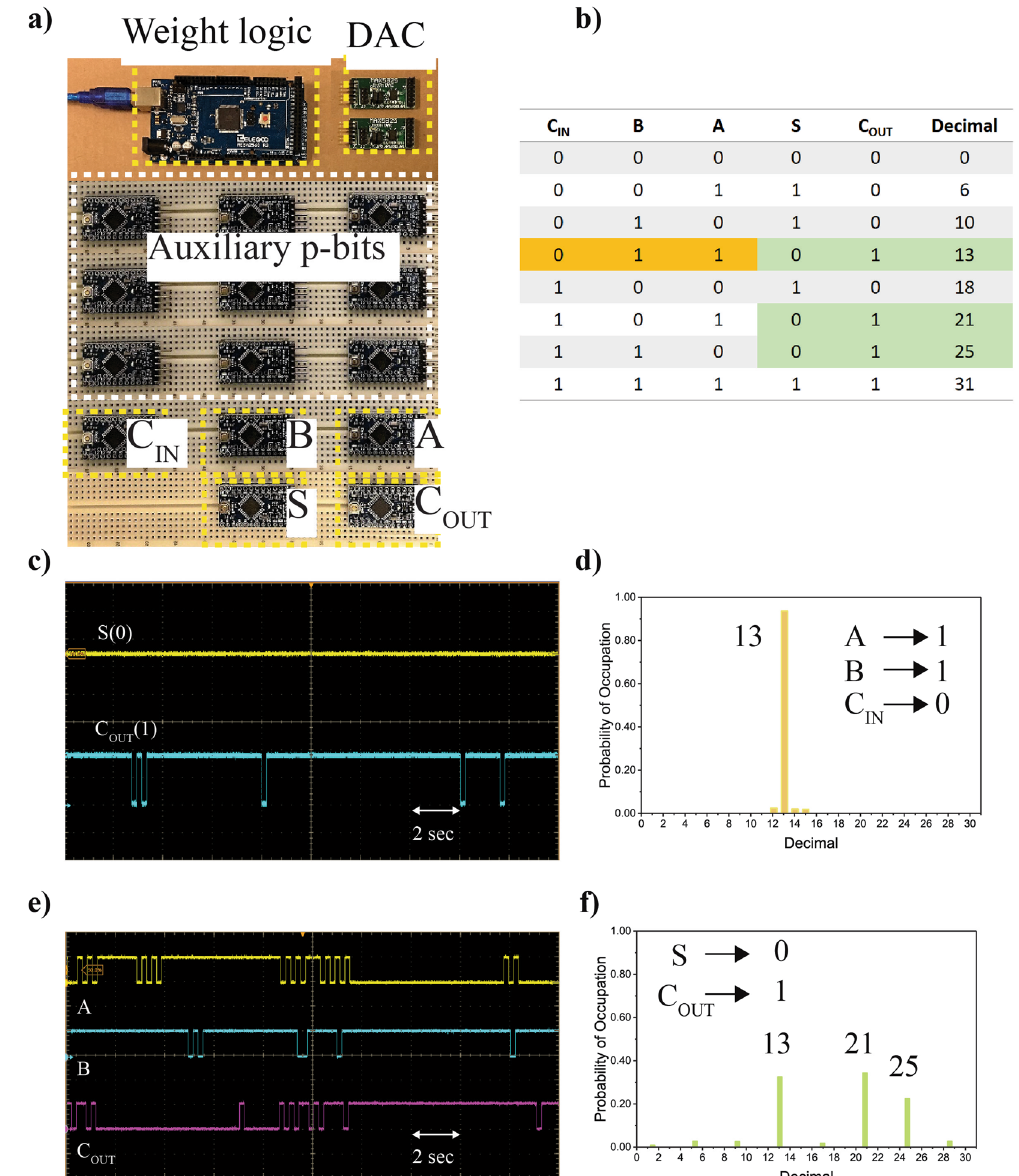
Figure 7. Full Adder. A Full Adder is implemented using 14 p-bits as shown in ( a ) along with its truth table in ( b ). The electrical wires connecting the components are not shown for clarity. ( c ) When the inputs A, B and C IN are clamped to 1,1 and 0 respectively, the Full Adder performs binary addition which can be seen from the time evolution of S and C OUT on the osilloscope. ( d ) The steady-state statistics acquired through serial logging are shown in ( d ). Since the Full Adder is bidirectional similar to the AND gate, the outputs C OUT and S can be clamped to 1 and 0 respectively, that cause the inputs A, B and C IN fluctuate among three states consistent with lines in the truth table as shown in ( e ) and ( f